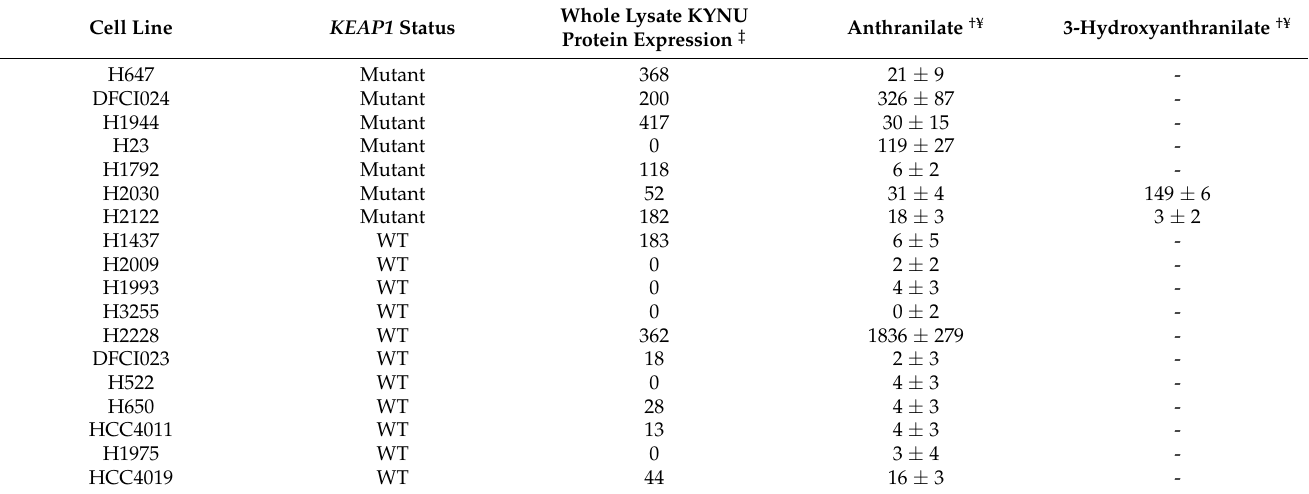
Table A3. Secretion or uptake rates for anthranilate and 3-hydroxyanthranilate for 18 lung adenocar- cinoma cell